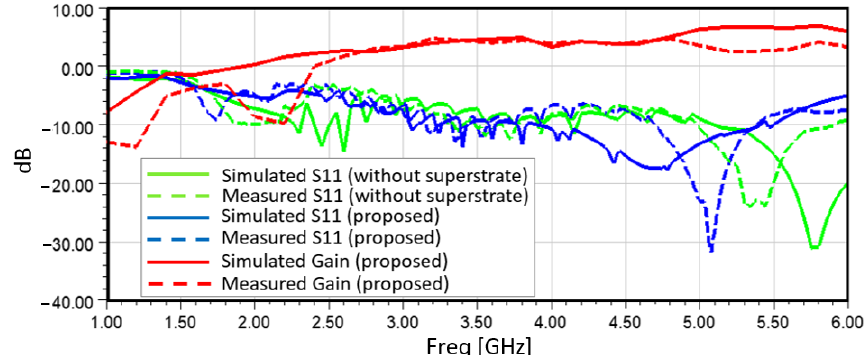
Figure 10. Reflection coefficient and gain of the fabricated prototype of the proposed antenna 1.